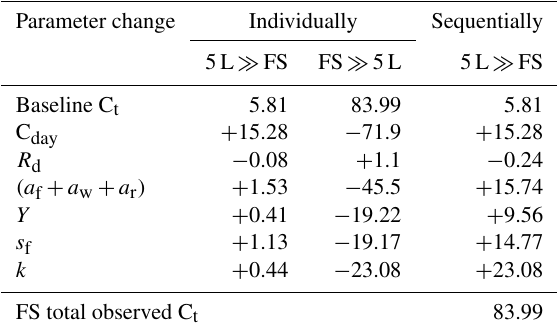
Table 4. Estimates of final biomass due to parameter change (in- dividual and sequential), showing the contribution of each parame- ter separately and successively to biomass changes. All values in gCplant − 1 . + / − indicates biomass increase or decrease due to particular parameter change. The final column corresponds to the changes shown in Fig.